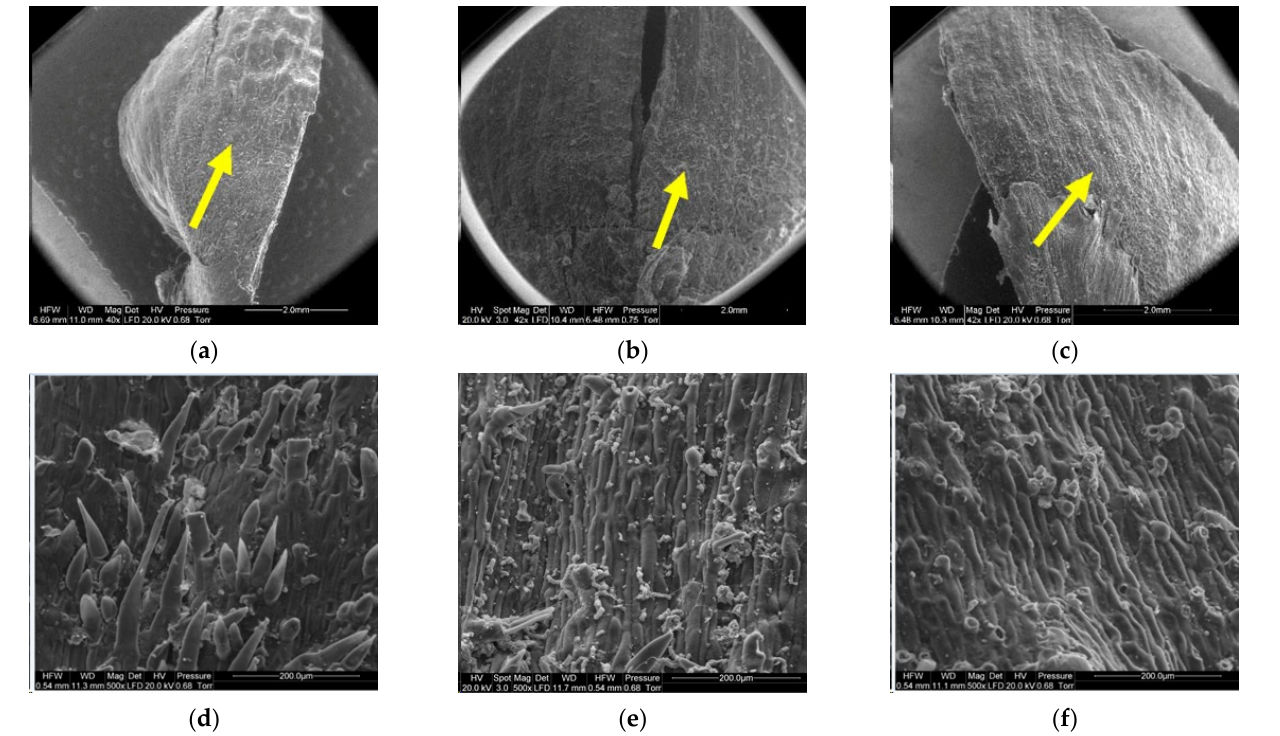
Figure 12. Outer side of larch scale. Middle scale area, adjoin by a lower scale: ( a ) MC = 20%, zoom 50×; ( b ) MC = 10%, zoom 50×; ( c ) MC = 5%, zoom 50×; ( d ) MC = 20%, zoom 500×; ( e ) MC = 10%, zoom 500×; and ( f ) MC = 5%, zoom 500×.